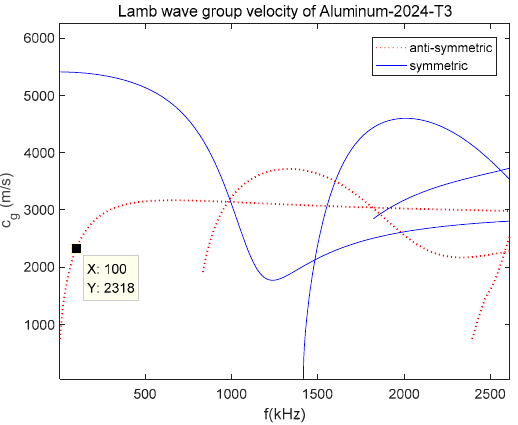
Figure 1. Dispersion curve for a smooth aluminum alloy plate with thickness of 2 mm.